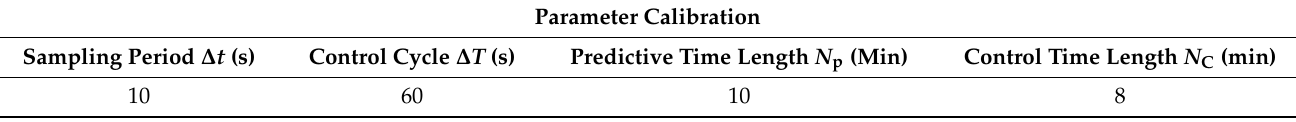
Table 6. MPC parameter calibration